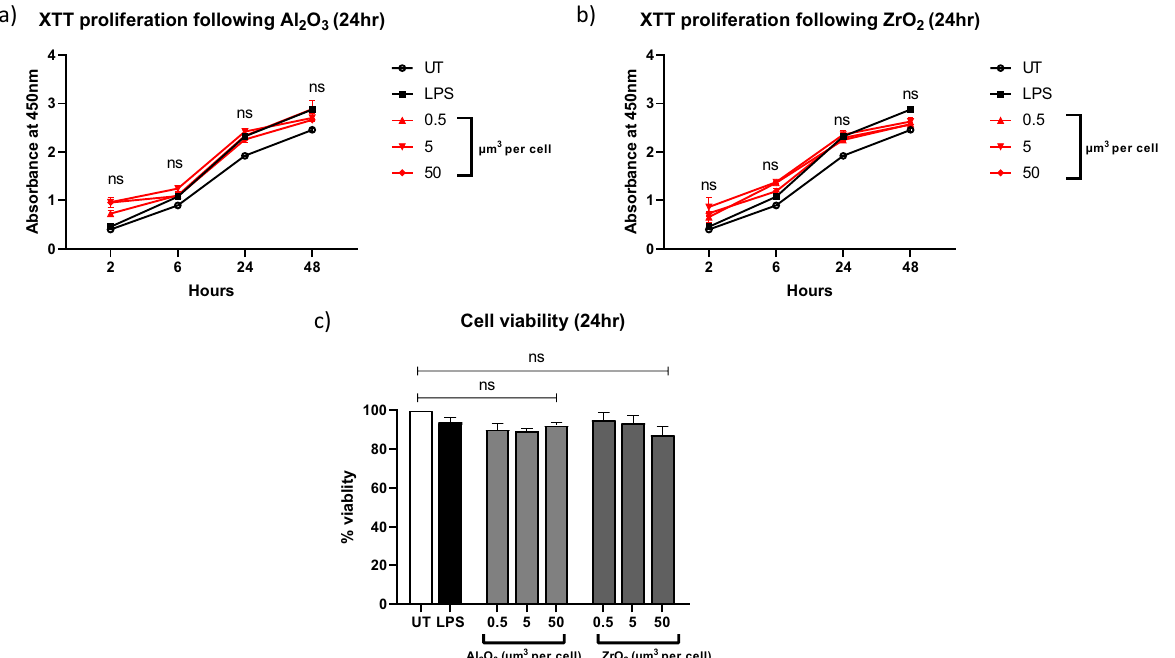
Figure 2. Cell viability and cellular proliferation following treatment with ceramic oxide nanopowders. THP-1 cells were treated for 24 h with 0.5–50 μm 3 particles per cell Al 2 O 3 or ZrO 2 or LPS (10 ng/mL) before being assessed for viability and proliferation. ( a ) After treatment with Al 2 O 3 for 24 h, cells were used in conjunction with the XTT platform and absorbance was measured on a nanoplate reader at 450 nm at 2–48 h timepoints. At each time point there was minimal difference between treatment groups and all groups following an increasing trend over the 48-h time course. The cells which received the highest dose of Al 2 O 3 at 2 h (P = 0.0559), 6 h (0.2061), 24 h (P = 0.9996) and 48 h (P = 0.6275) saw no significant changes in absorbance following treatment with XTT. ( b ) Cells which were treated with ZrO 2 for 24 h were then used for XTT proliferation analysis over a 2–48 h time course. ZrO 2 -treated cells saw no significant difference in absorbance when compared to untreated at 2 h (P = 02,867), 6 h (0.0577), 24 h (P = 0.9998), and 48 h (0.9714) at the highest dose. ( c ) Following a 24-h treatment with ceramic oxides or LPS, THP-1 cells were harvested and stained with trypan blue before being counted and normalised to the untreated control. There were no significant changes in cell viability between any treatment group and the control cells even at the highest concentrations of both Al 2 O 3 (P = 0.5984) and ZrO 2 (P = 0.1142). Graphs are represented of n =